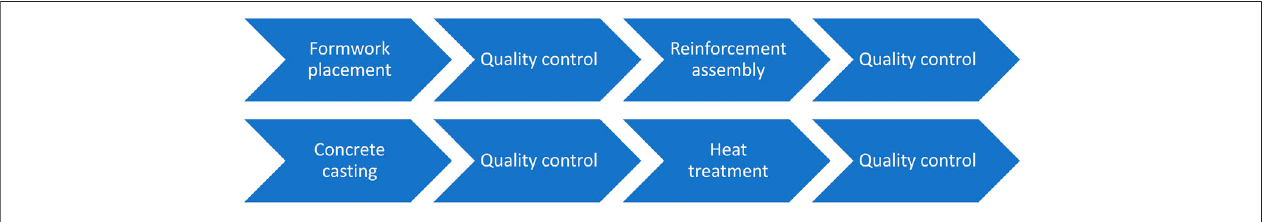
FIGURE 2 | Production and quality control steps for precast concrete